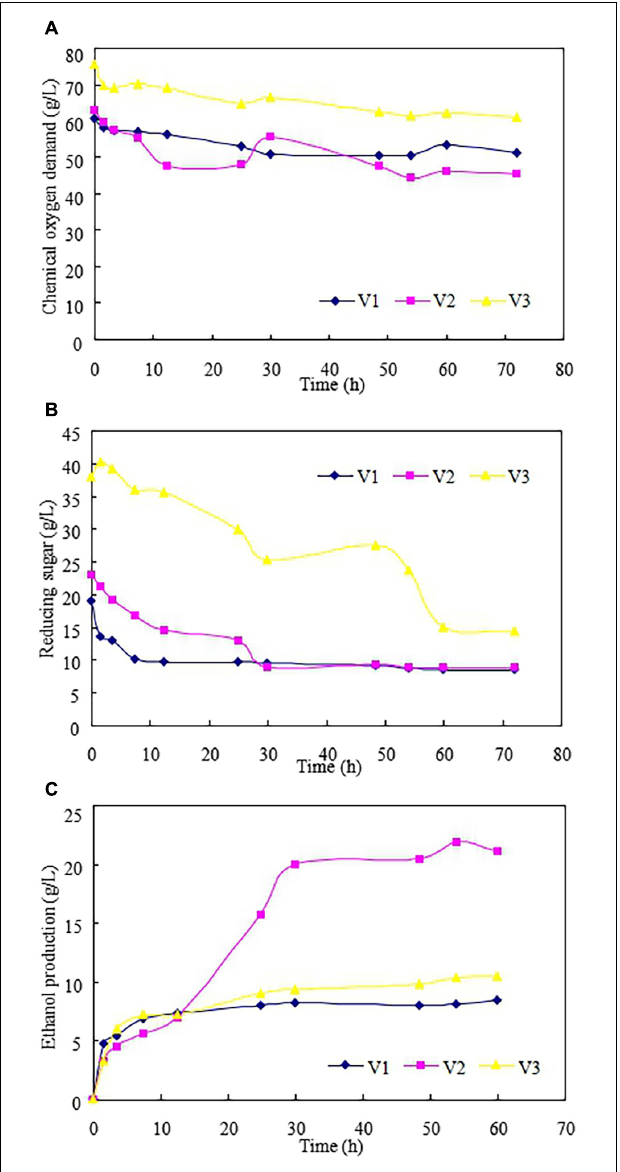
FIGURE 4 | Fermentative ethanol production from enzymatic hydrolysis of leftover cooked rice.